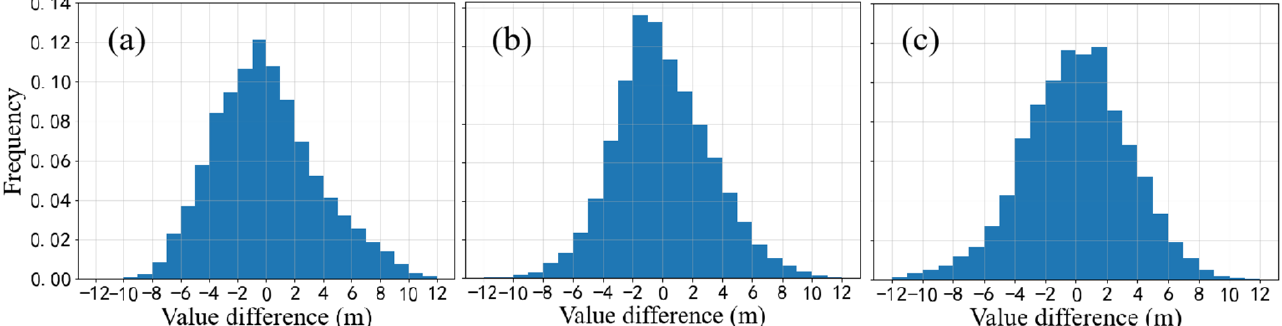
Figure 15. Difference distribution of predicted water depths in areas ( a ) A2, ( b ) A3, and ( c ) A4. Table 2. Accuracy of predicted water depths within areas: A2, A3, and A4. Region A2 Region A3 Region A4 Mean absolute error (m) 2.90 2.56 2.73 Root mean square error (m) 3.67 3.31 3.46 Area size (km 2 ) 224 202